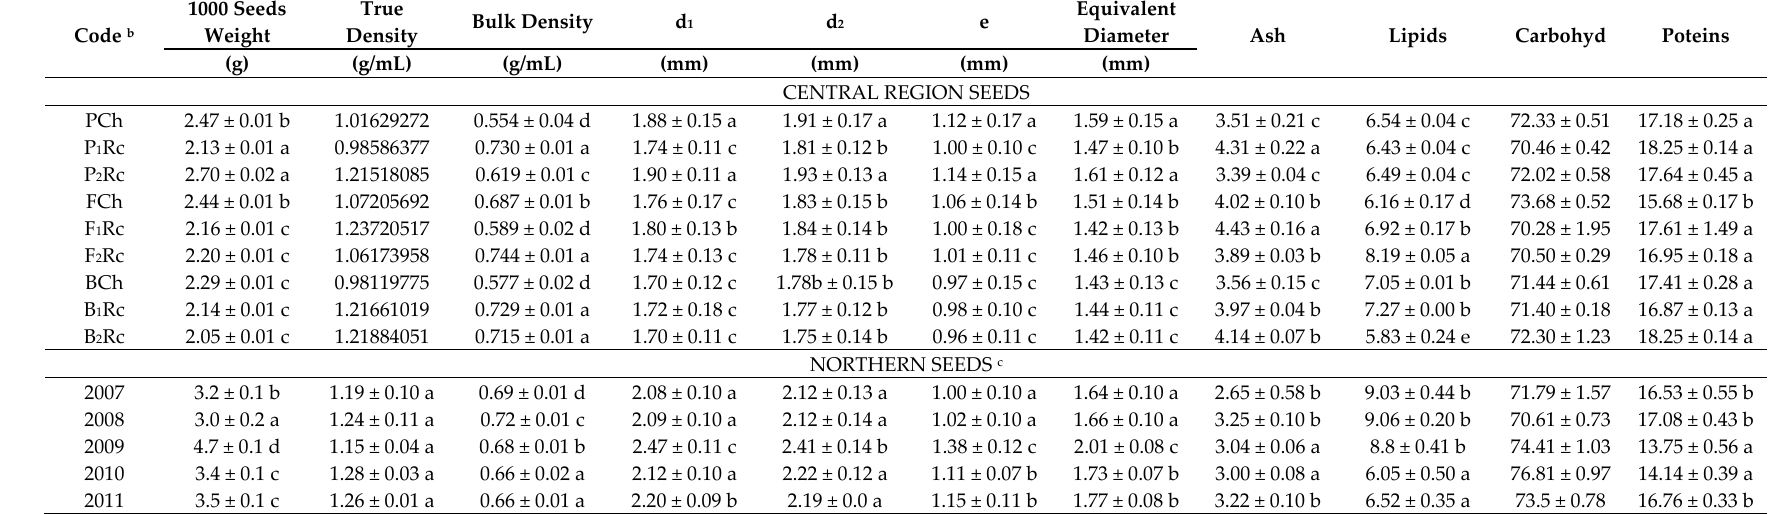
Table 1. Gravimetric, dimensional properties and proximal composition of quinoa seeds a